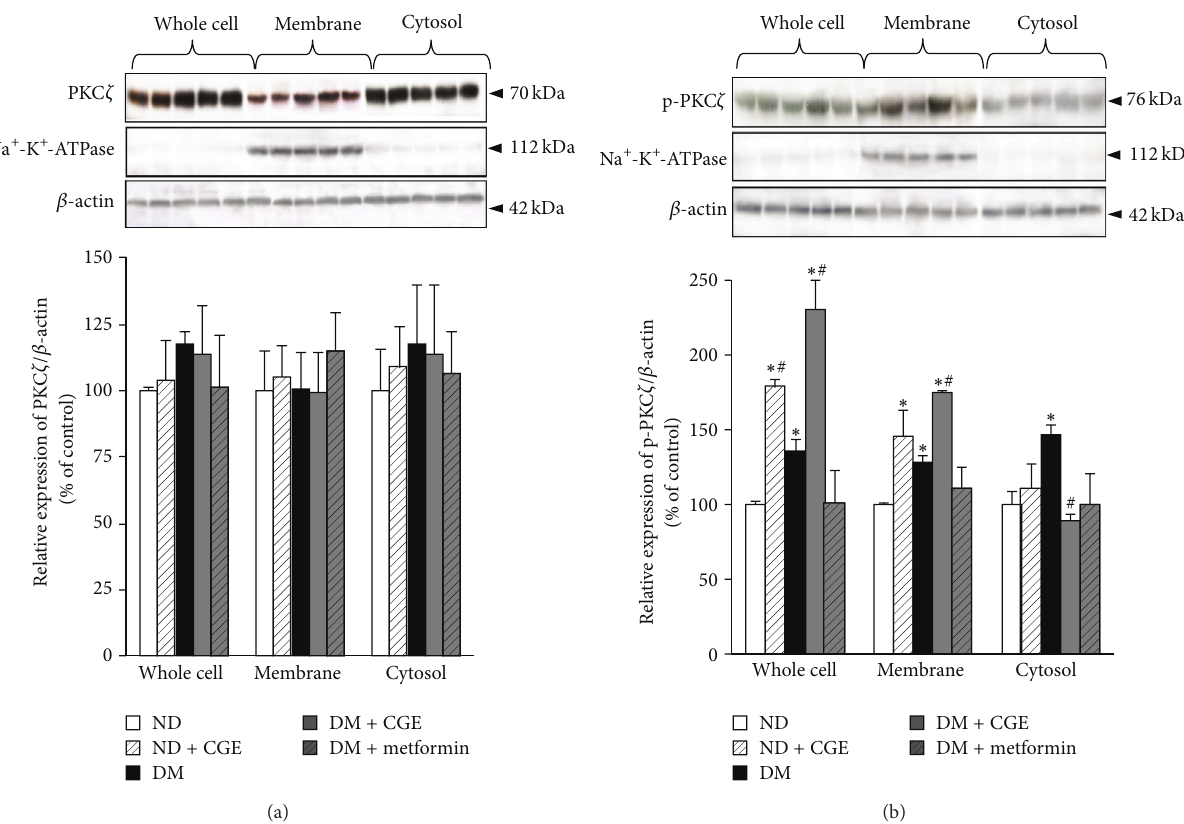
Figure 6: Effects of Cladophora glomerata extract on PKC 𝜁 expression, activation, and translocation in renal cortical tissues. Whole cell lysate, cytosolic, and nuclei fractions were extracted from rat renal cortical tissues. The samples were then separated using electrophoresis and western blotting. (a) Anti-PKC 𝜁 and (b) p-PKC 𝜁 antibodies were subsequently detected while anti-Na + -K + -ATPase and anti- 𝛽 -actin antibodies were used as a membrane marker and loading control, respectively. The data are expressed as mean ± SD and repeated from separate sets of animals ( 𝑛 = 5 ). A representative blot of PKC 𝜁 and p-PKC 𝜁 protein expressions is shown in top panel ((a) and (b)) and quantification of relative protein expression in each fraction is presented in bottom panel ((a) and